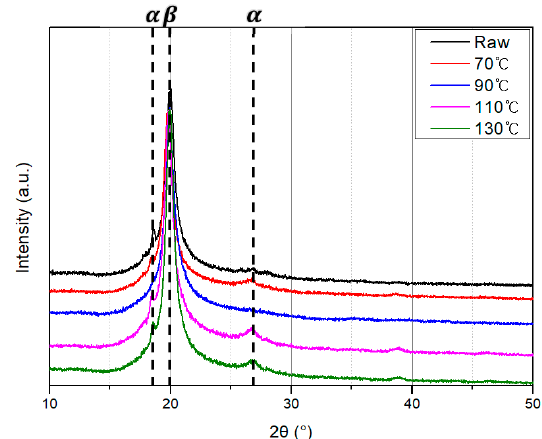
Figure 11. XRD patterns of the PVDF/PAR composite as drawing temperature (Unpoled).